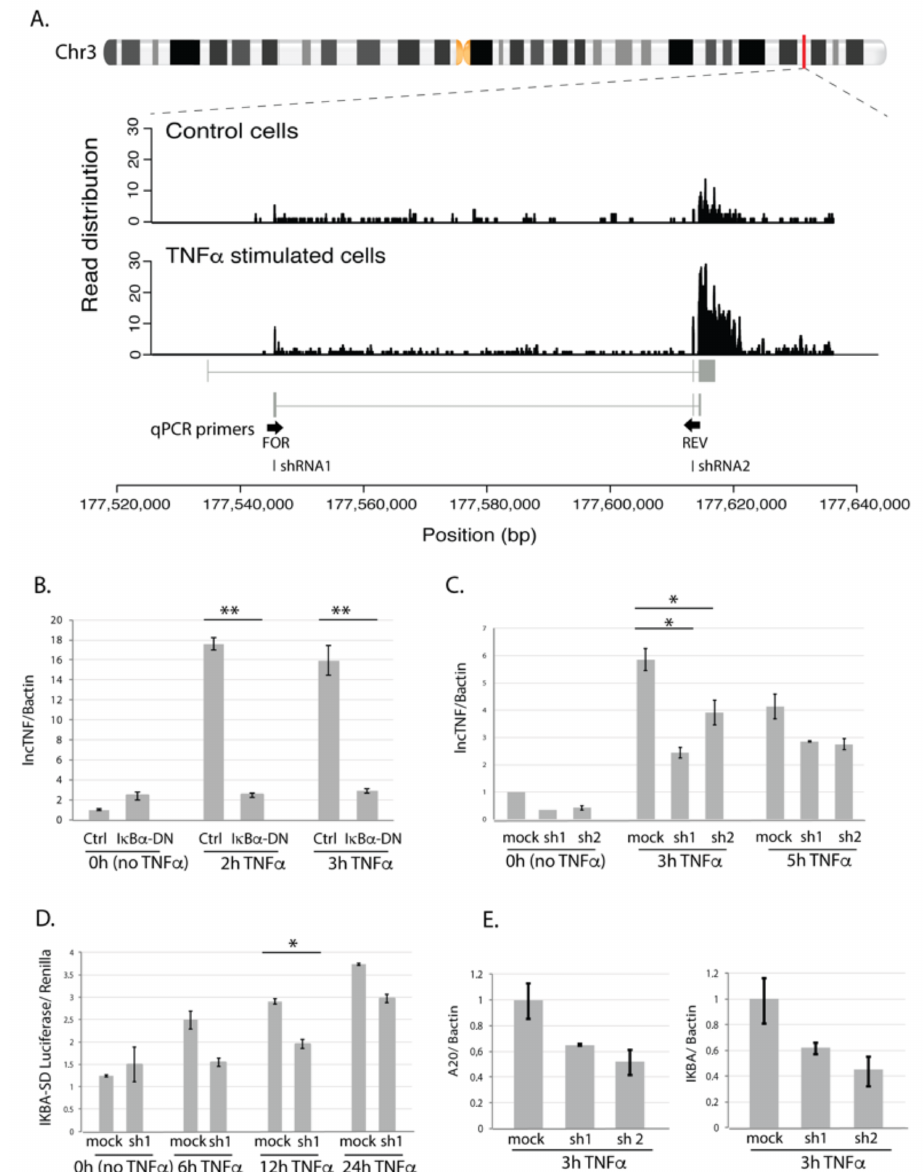
Figure 4. LncTNF structure and function. ( A ) Chromosomal location of lncTNF and read distribution based on the RNA sequencing in control (BSA-treated, all time points) and TNF α -stimulated cells (all time points). qPCR primers are located in exon 1 (forward primer) and exon 2 (reverse primer). shRNAs used for knock-down experiments are located in exon 1 (shRNA1) and exon 2 (shRNA2). ( B ) Gene expression of lncTNF relative to the Bactin ( y -axis) measured by qPCR in HepG2 cells transduced with adenovirus containing I κ B α dominant negative construct (Ad5I κ B; I κ B α -DN) and cells transfected with Cre adenovirus used as control ( x -axis). Three time points were analyzed (0 h or no stimulation, 3 h, and 5 h of TNF α stimulation). ( C ) Gene expression of lncTNF relative to Bactin ( y -axis) upon lncTNF knock-down using two different shRNAs (shRNA1 and 2) and three time points ( x -axis). Scrambled shRNA sequence was used as control (mock). ( D ) Activity of NF- κ B measured by luciferase/renilla ratio ( y -axis) in lncTNF-KD cells (shRNA1) compared to mock control cells ( x -axis). Transfected cells were stimulated with TNF α for 6, 12, and 24 h or not stimulated (0 h). ( E ) Gene expression level of A20 and IKBA relative to Bactin ( y -axis) in lncTNF-KD cells and mock control cells upon 3 h TNF α stimulation. Values represent mean ± SEM, * = p ≤ 0.05, ** = p <